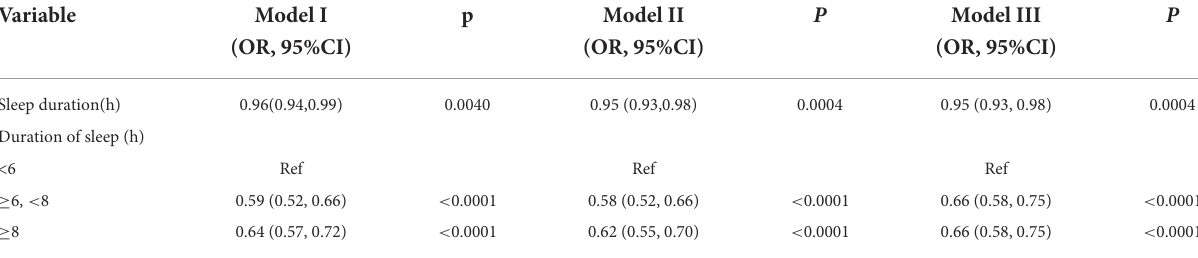
TABLE 2 Relationship between sleep duration and chest